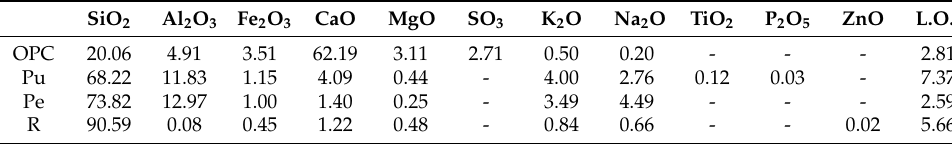
Table 1. Chemical analysis (% w / w ) of used materials.